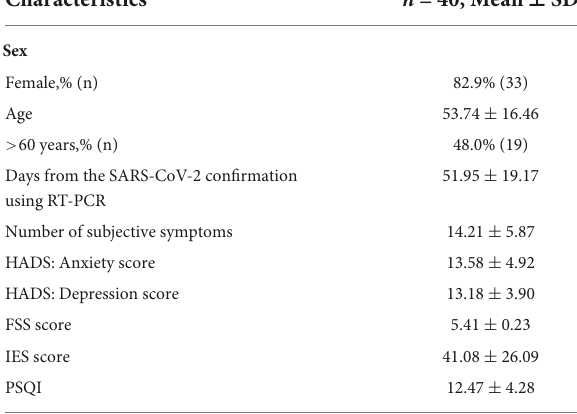
TABLE 2 Demographic and clinical characteristics of the participants ( n =